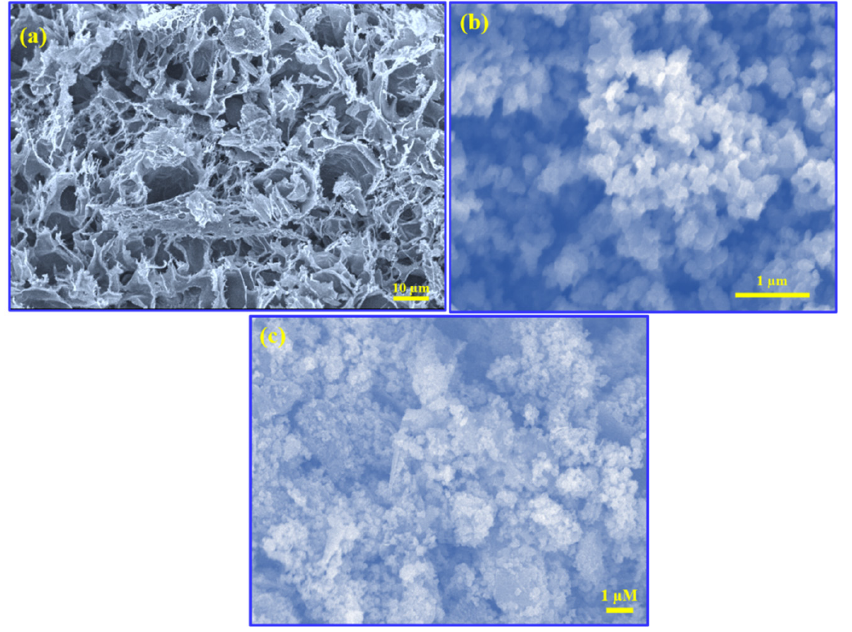
Figure 2. ( a ) SEM image of LSG. ( b ) SEM image of PB-PEDOT. ( c ) SEM image of